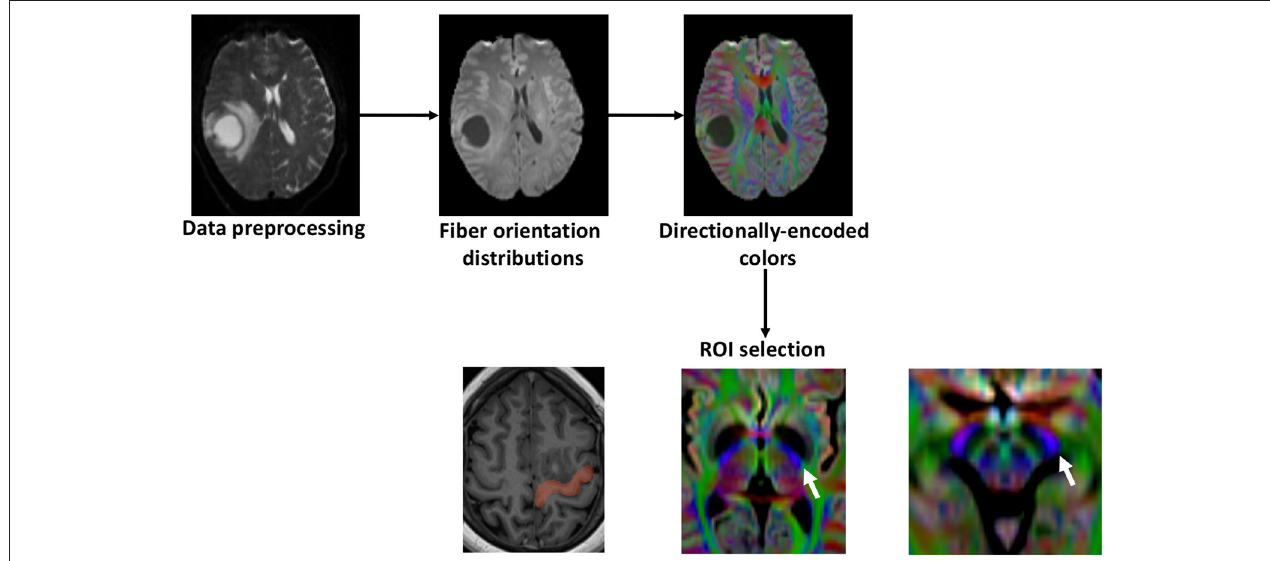
FIGURE 1 | Study outline. First, diffusion weighted images were preprocessed with subject-motion, Eddy current distortion, and bias field correction. Fiber orientation distributions were calculated with constrained-spherical deconvolution and the directionally-encoded colors were obtained. The precentral gyrus was delineated using the T1 and defined as the seed region of interest (ROI). The other inclusion ROIs were selected in the directionally-encoded colors sequence based on the described trajectory of the motor CST. The posterior half of the posterior limb of the internal capsule and the posterolateral third of the cerebral peduncle (white arrows).